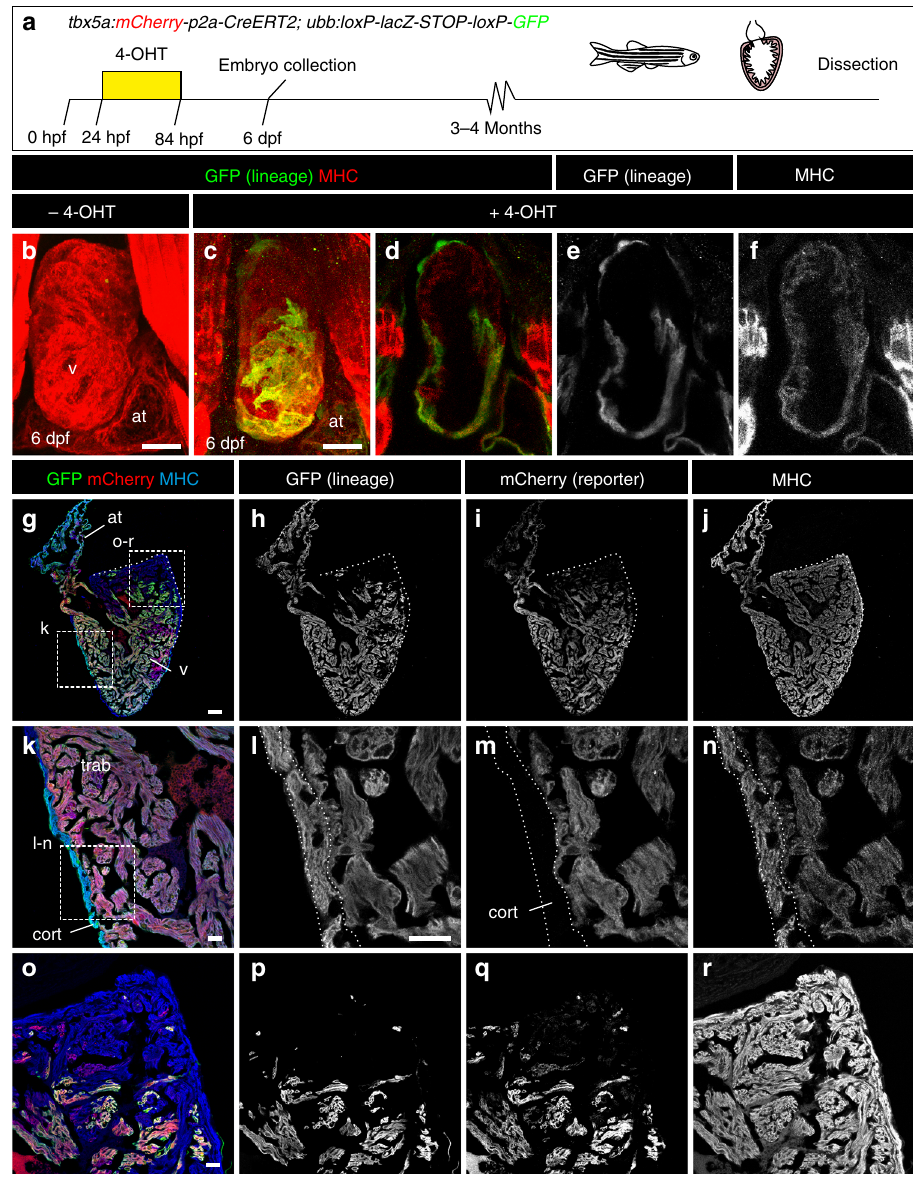
Fig. 3 Fate mapping of tbx5a -derived cells during cardiac development. a tbx5a : mCherry-p2A-CreER T2 ;ubb : loxP-LacZ-STOP-loxP-GFP hearts fi xed at different developmental stages. mCherry marks tbx5a -expressing cells; GFP marks tbx5a -derived cells. b – f Whole-mount ventral view of hearts at 6 days postfertilisation (dpf) stained for GFP (green) and Myosin Heavy Chain (MHC, red). b In the absence of 4- Hydroxytamoxifen (4-OHT) administration, no GFP + cells are visible ( n = 5/5). c – f 4-OHT was added from 24 to 84 hours postfertilisation (hpf). GFP expression is observed in the proximal part of the ventricle; n = 8/8. In some cases, GFP expression was also found in epicardial cells located in the distal part of the ventricle. g – r Immuno fl uorescence staining of adult heart sections recombined as in c . Shown are merged and single channels for GFP (green), mCherry (red), and anti- MHC staining (blue); n = 5/5. at, atrium; cort, cortical layer; trab, trabecular layer; v, ventricle. Scale bars, g 100 μ m and b , c , k , l , o 25 μ with the exception of the distal-most part at the cranial pole (Fig. 4b, c, n = 7/7). In adult hearts, most ventricular cardio- chain like ( vmhcl ) cis -regulatory elements (Fig. 4a; Supplementary myocytes were mCherry + . Only a small portion of cardiomyo- Fig. 9; n = 10/10). vmhcl is expressed exclusively in ventricular and not atrial cardiomyocytes 27 . We crossed vmhcl:loxP-tagBFP- cytes close to the BA and AVC was tagBFP + (Fig. 4d, e), loxP-mCherry-NTR with tbx5a:CreER T2 . This allowed to lineage- coinciding with the results obtained doing lineage tracing using − ventricular cardiomyocytes trace tbx5a + (mCherry + ) and tbx5a tbx5a : mCherry-p2A-CreER T2 ; ubb : loxP-lacZ-STOP-loxP-GFP . To (tagBFP + ). Furthermore, this genetic strategy allows the ablation speci fi cally ablate mCherry + cardiomyocytes we administered of tbx5a + ventricular cardiomyocytes by adding Metronidazole Mtz from 4 to 7 dpf (Supplementary Fig. 10). Surprisingly, 30 days later, a complete ventricle had regenerated from tagBFP + (Mtz) to induce cell death in nitroreductase (NTR)-expressing cells 28 . Administration of 4-OHT from 24 to 48 hpf induced the cardiomyocytes, suggesting that SHF-derived ventricular cardio- expression of mCherry-NTR in tbx5a -derived cardiomyocytes in myocytes are able to compensate the genetic ablation of the FHF- the trabecular and primordial layer of the embryonic ventricle, derived ventricular myocardium ( n = 6/6; Fig. 4f – h and